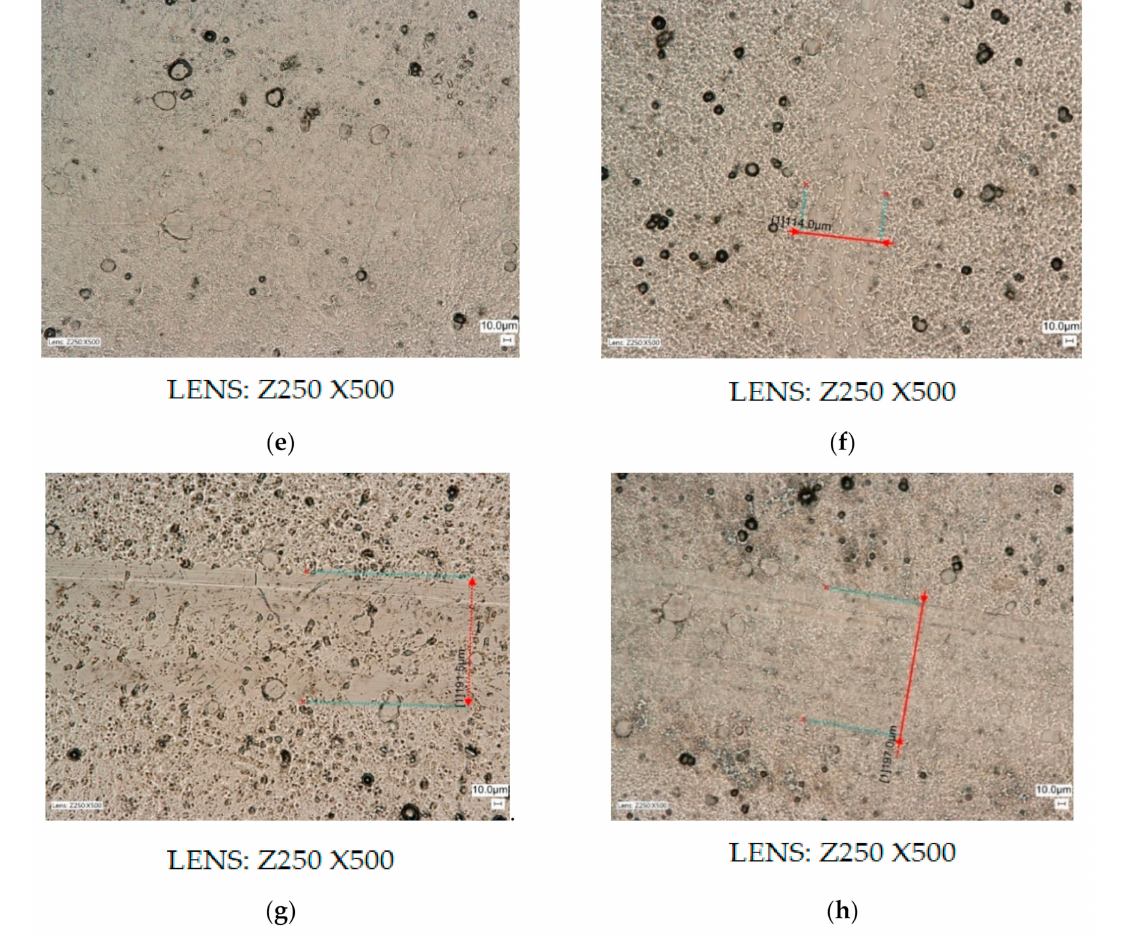
Figure 9. Samples of AW-7075 alloy without coating and with Ni-P and Ni-P / Si 3 N 4 layers. (( a )—AW-7075, ( b )—Ni-P (10), ( c )—Ni-P (20), ( d )—Ni-P (30), ( e , g )—Ni-P / Si 3 N 4 (2g), ( f , h )—Ni-P / Si 3 N 4 (5g); crack widths ( µ m): ( a )—78.2, ( b )—148.9, ( c )—216.1, ( d )—138.7, ( e )—no scratches, ( f )—114.0, ( g )—191.5, ( h )—197.0).